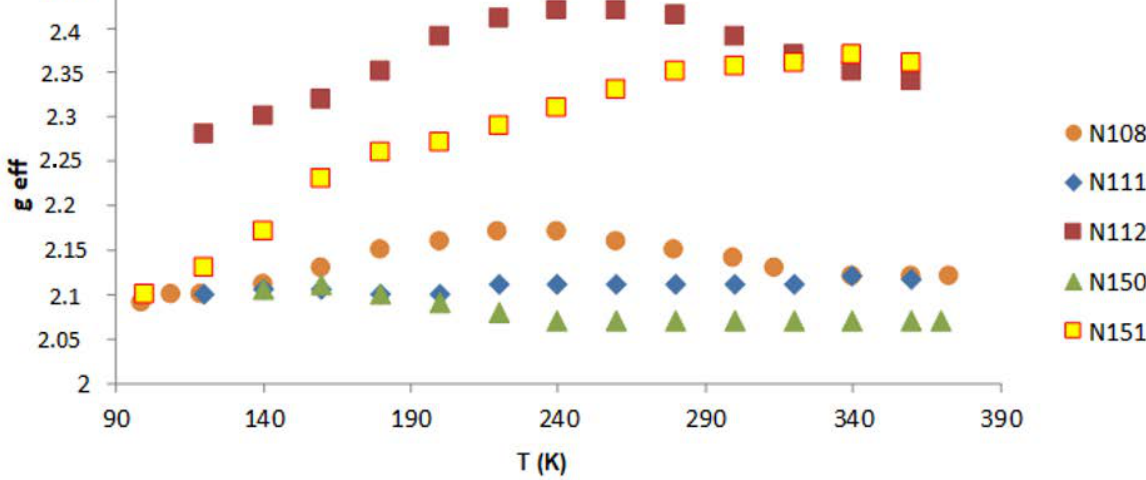
Figure 7. g eff as a function of the temperature for Pb 3+ (g eff ≈ 2).